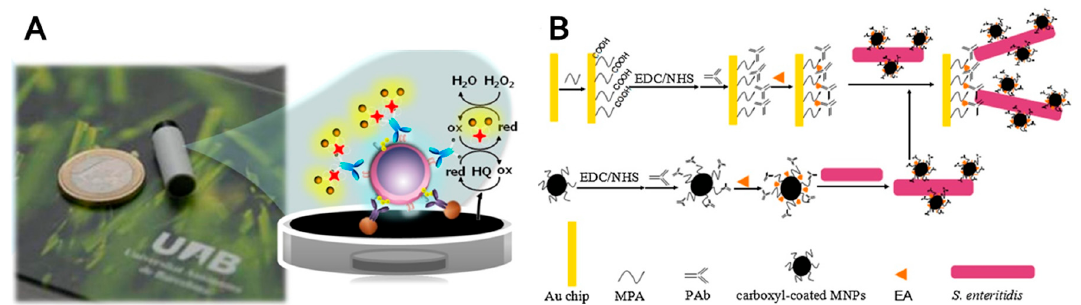
Figure 6. ( A ) Working electrode and scheme of target cell amperometric detection using horseradish peroxidase enzymatic activity, H 2 O 2 as a substrate and hydroquionone (HQ) as an electron mediator; ( B ) The schematic representation of S. enteritidis detection using a magnetic particles-enhanced surface plasmon resonance sandwich assay. (Reproduced with permission from [211,212], respectively).